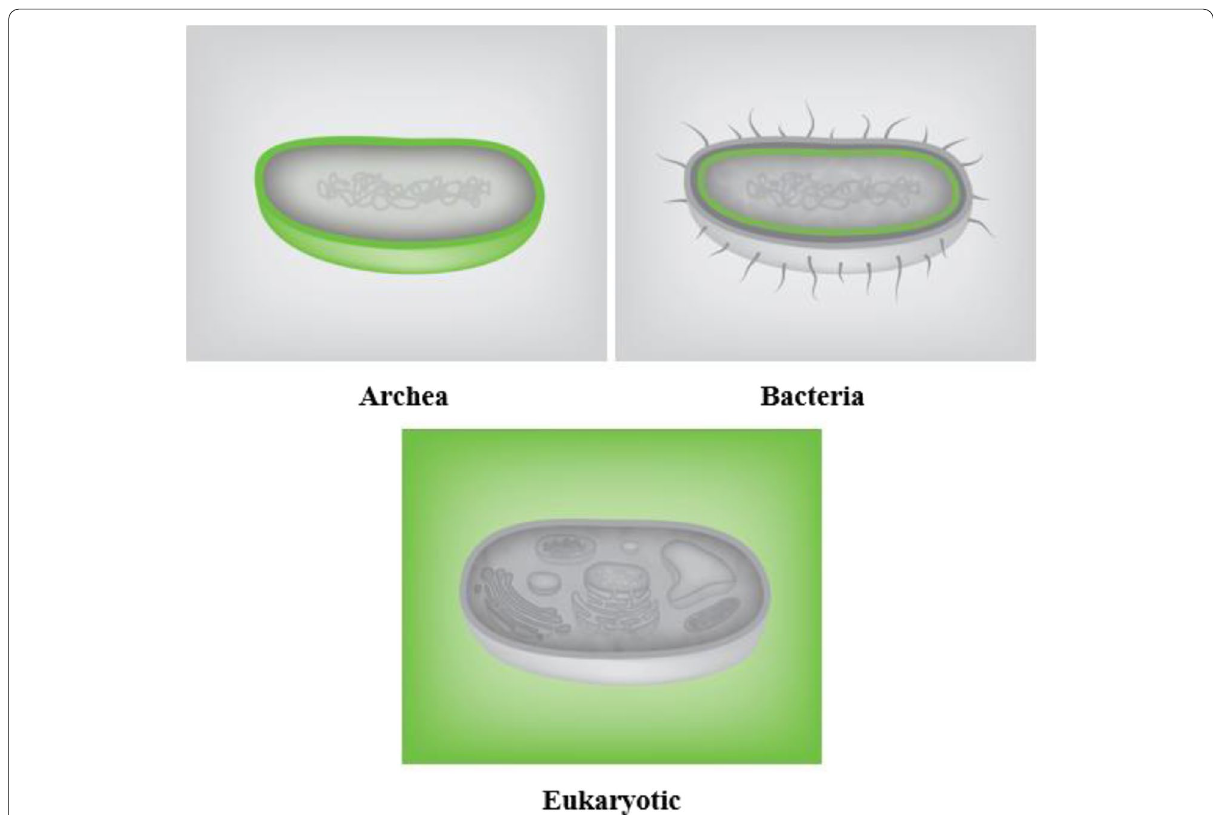
Fig. 2 Cell penetration model of β-defensin